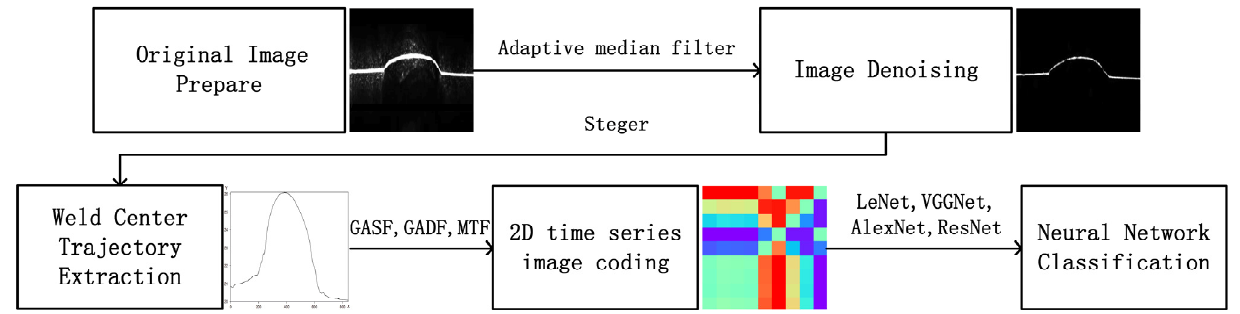
Figure 2. Flow chart for the proposed method.